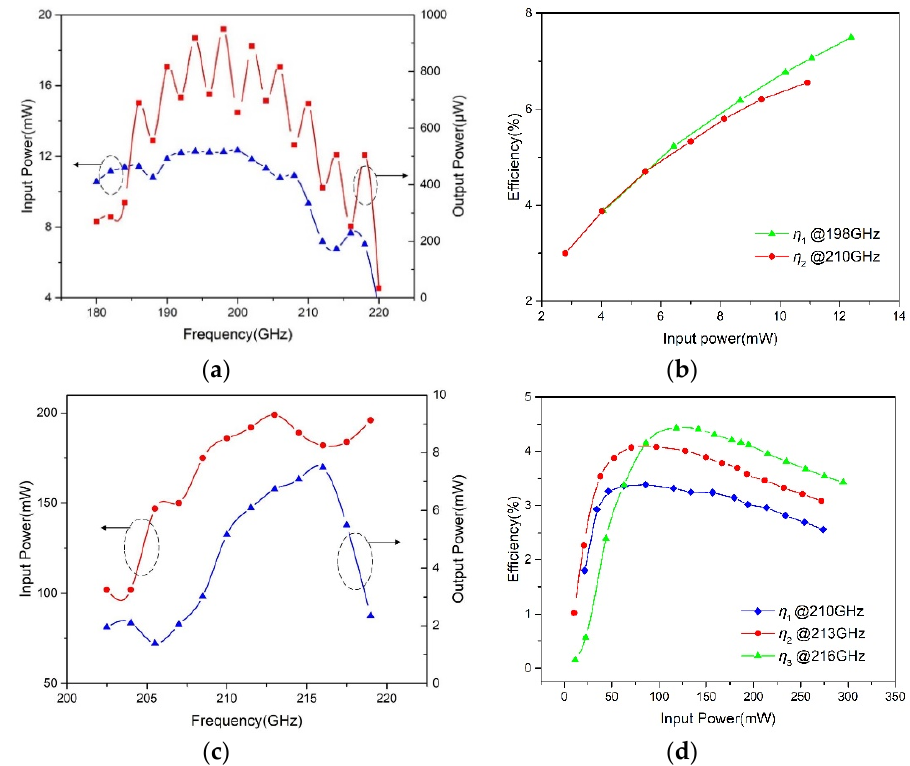
Figure 7. Measured results of frequency multipliers. ( a ) Measured input and output power of the 200 GHz doubler as a function of frequency; ( b ) Measured efficiency of the 200 GHz doubler as a function of input power at fixed frequency; ( c ) Measured input and output power of the 215 GHz tripler as a function of frequency; ( d ) Measured efficiency of 215 GHz tripler as a function of input power at fixed frequency.